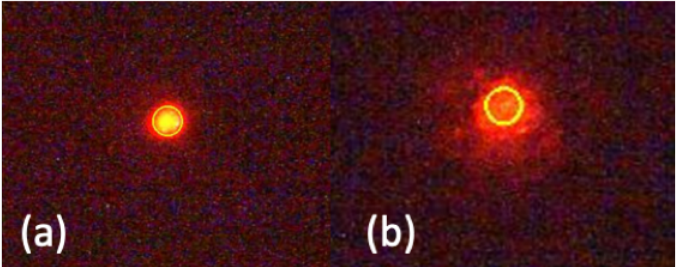
Figure 8. Fluorescent microscopy images of the cells collected at ( a ) CTC outlet and ( b ) waste outlet. CTCs collected at the waste outlet have lost the integrity, as exemplified by the irregular shape of the cell in ( b ). Yellow circles are overlaid by the utilized cell counting